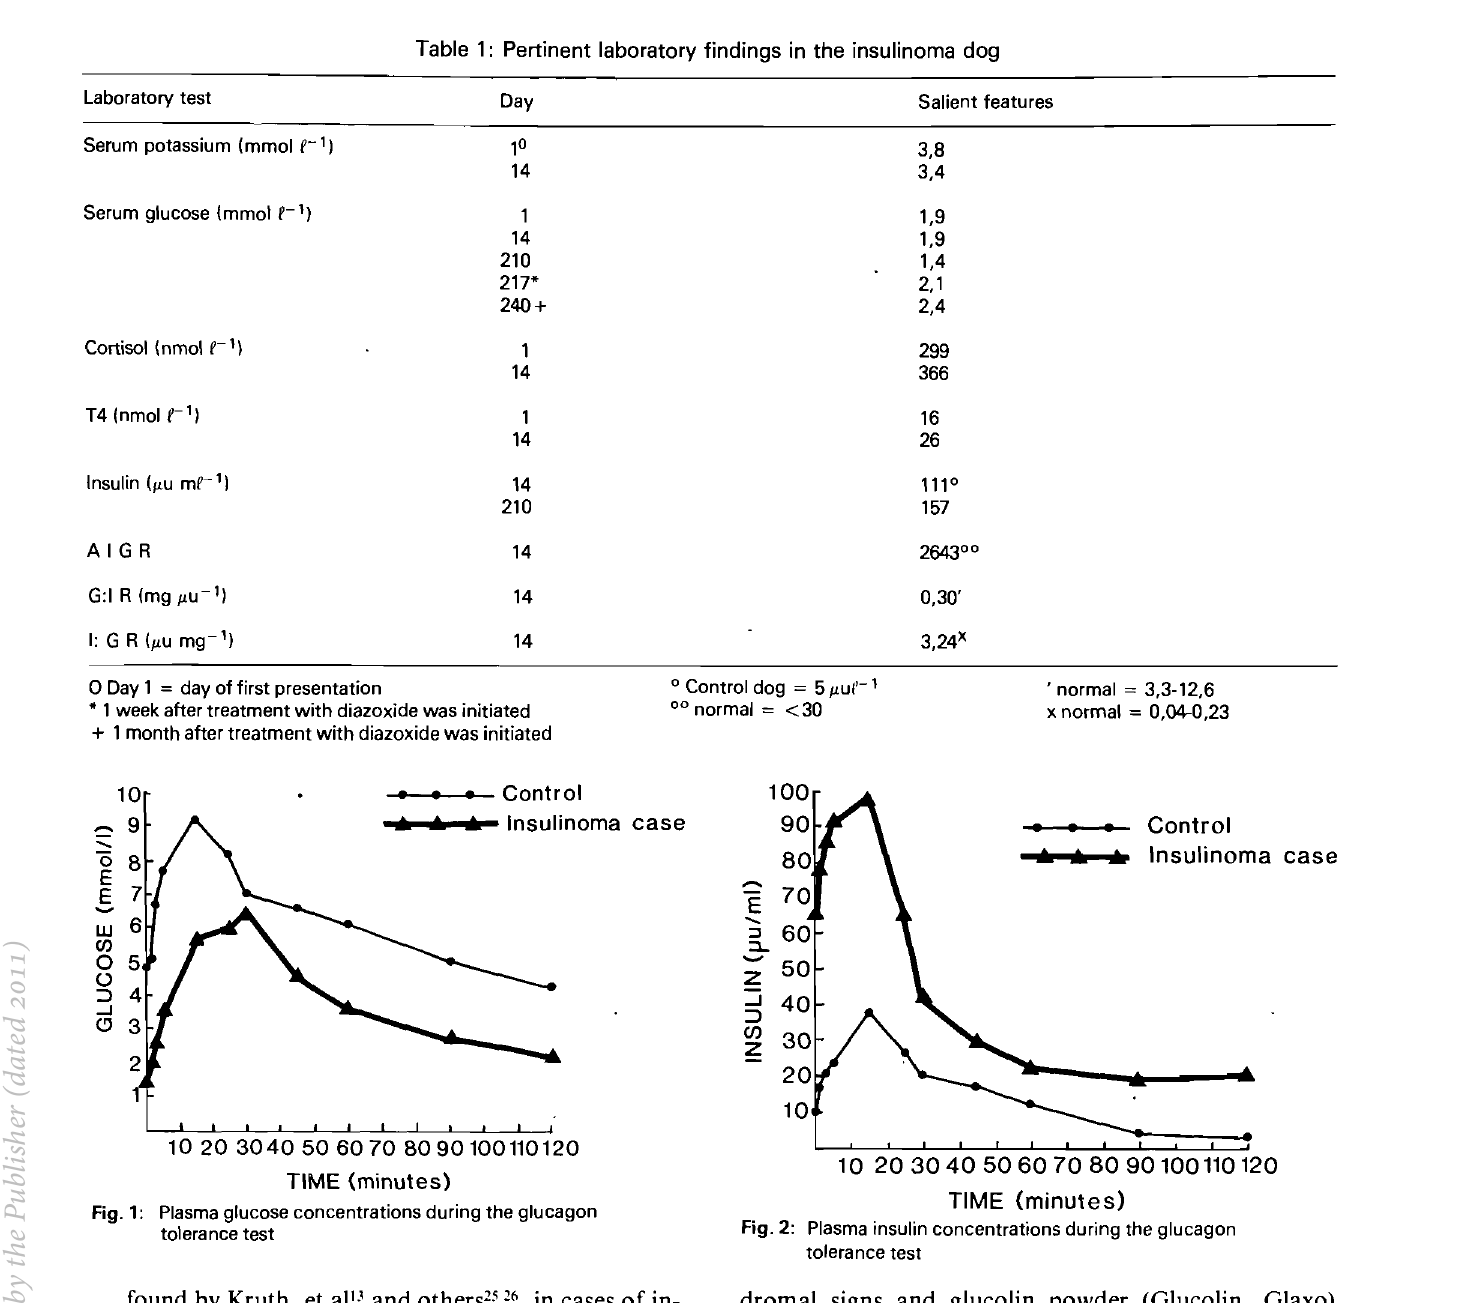
Fig. 2: Plasma insulin concentrations during the glucagon tolera nce test dromal signs and glucolin powder (Glucolin, Glaxo) with water had to be given orally when